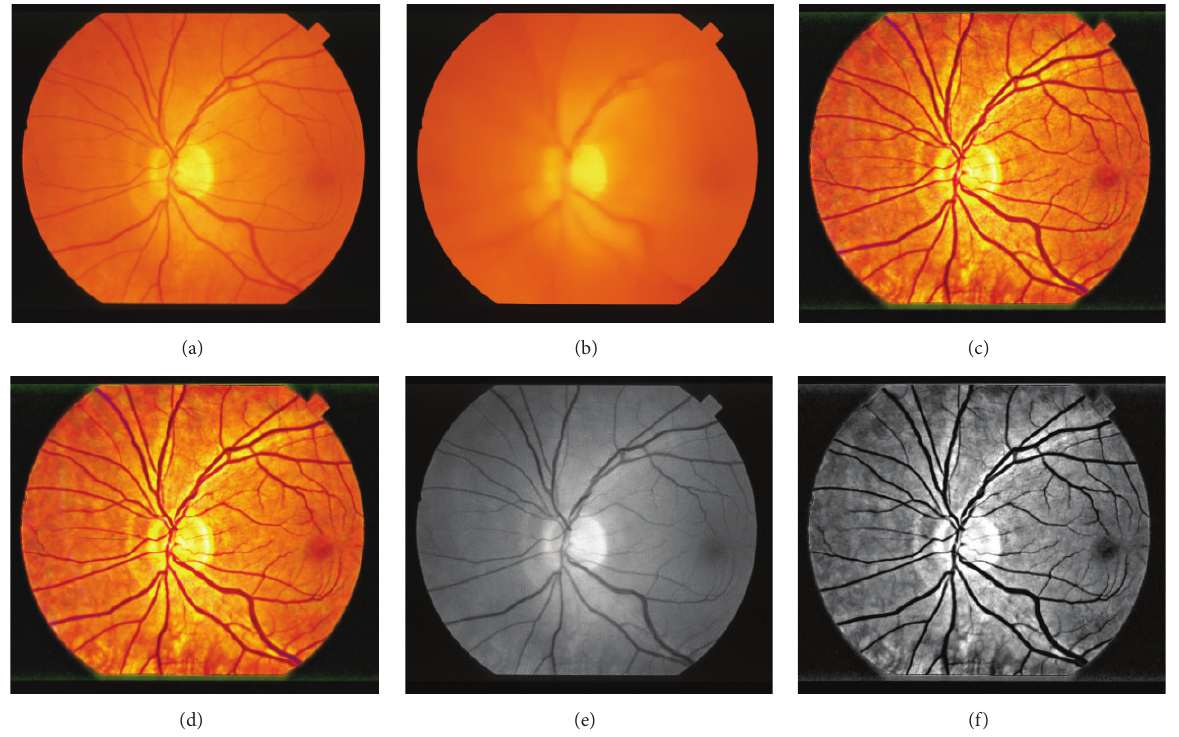
Figure 5: The image enhancement results of an image selected from the STARE database. (a) Original image; (b) normalized convolution result; (c) fusion result; (d) denoising result; (e) green channel of original image; (f) green channel of denoising result.